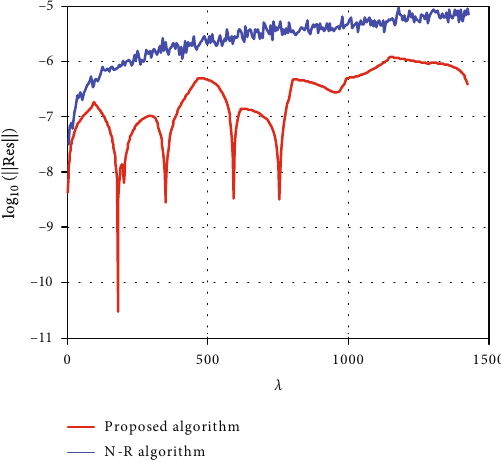
Figure 9: Initial and deformed con fi guration of the middle line obtained using the ANM algorithm.